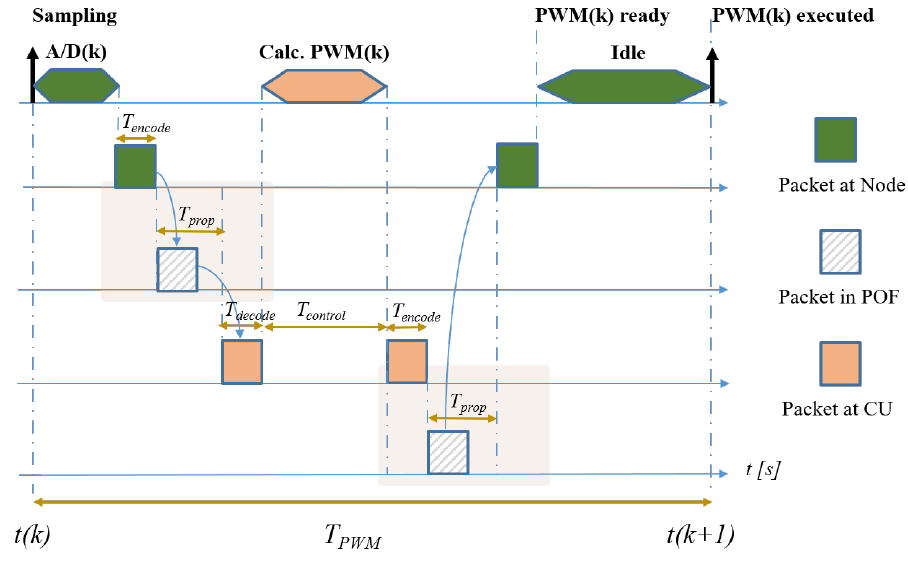
Figure 3. Timing diagram of the proposed optical link. POF, Plastic Optical Fiber; CU, Control